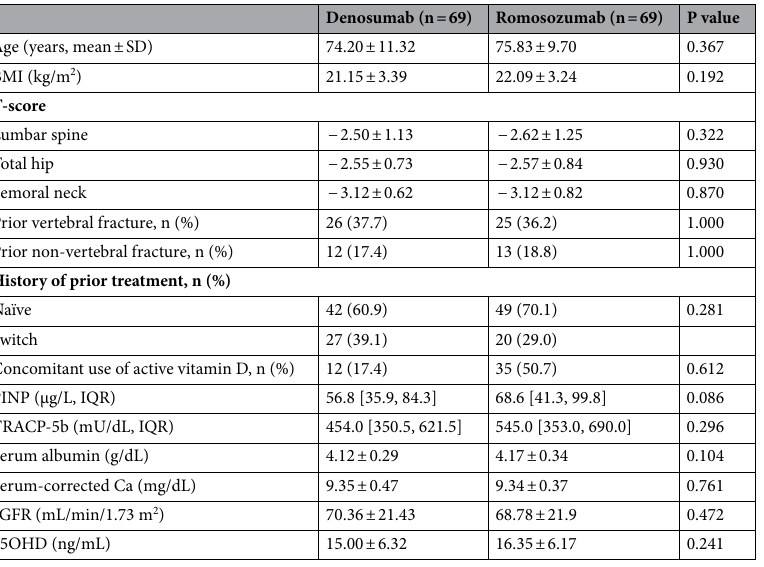
Table 2. Demographic and clinical characteristics of subjects at baseline after extraction by propensity score matching. Data are expressed as the mean ± standard deviation (SD) or the number (%) of subjects. P1NP and TRACP-5b are expressed as median values. BMI body mass index, P1NP procollagen type 1 N-terminal propeptide, TRACP-5b tartrate-resistant acid phosphatase isoform 5b, eGFR estimated glomerular filtration rate, 25OHD 25-hydroxyvitamin D; Differences between the groups were determined by ANOVA or Fisher’s exact